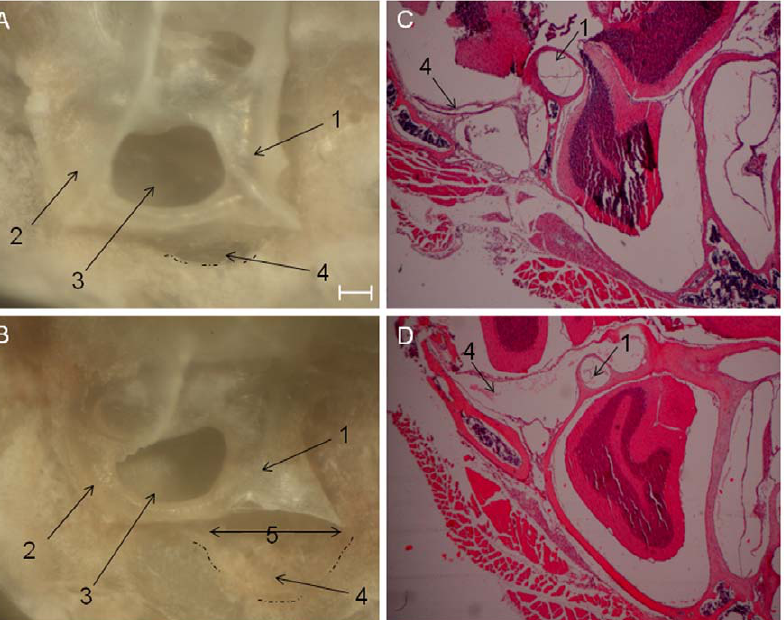
Figure 4. Structural aberrations of the vestibular aqueduct and endolymphatic sac in mice. The vestibular aqueduct and endolymphatic sac in the Slc26a4 tm1Dontuh/tm1Dontuh mice were enlarged (B & D) compared to those in the Slc26a4 + / + mice (A & C). (1, posterior semicircular canal; 2, superior semicircular canal; 3, subarcuate fossa; 4, fovea for endolymphatic sac (dot-dash line); 5, external orifice of vestibular aqueduct. Bar=100 m m. doi:10.1371/journal.pone.0022150.g004 PLoS ONE |